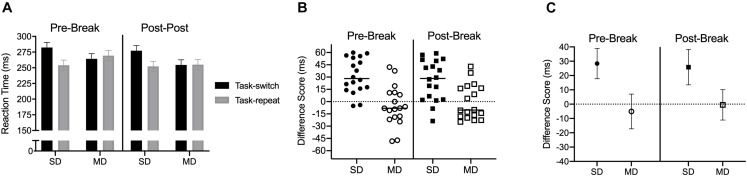
Experiment 2: Panel (A) presents group mean reaction time (RT) for pre- and post-break stimulus-driven and minimally delayed task-switch and task-repeat saccades with errors bars representing 95% within-participant difference scores. Panels (B,C) present participant-specific and group mean RT difference scores (task-switch minus task-repeat), respectively. The errors bars in (C) represent 95% between-participant confidence intervals.